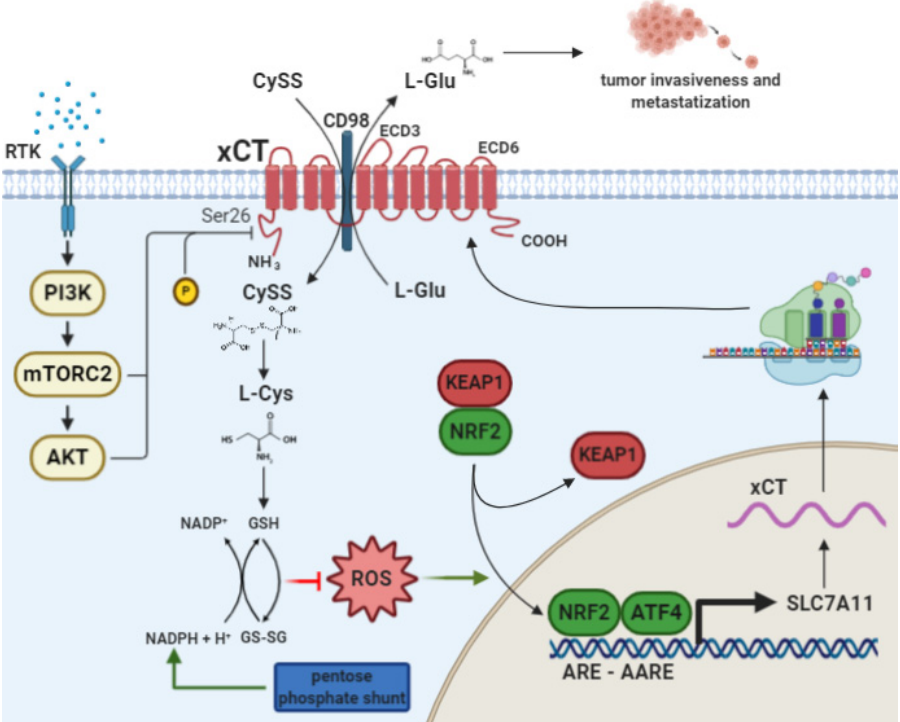
Figure 1. xCT function and transcriptional regulation. The cystine/glutamate antiporter xCT exports intracellular glutamate and imports extracellular cystine. Exported glutamate is involved in tumor microenvironment shaping, promoting invasiveness and metastasization. The imported cystine is reduced to cysteine and used for the biosynthesis of GSH, which is responsible for cancer cell protection from reactive oxygen species (ROS) excess due to genomic instability, altered metabolism and external insults, such as chemotherapy. ROS induce the upregulation of xCT, which destabilizes the KEAP1-NRF2 complex; NRF2 translocation into the nucleus and its binding to the ARE sequence on the SLC7A11 gene promoter lead to xCT mRNA transcription and protein production. Amino acid depletion also induces xCT upregulation through ATF4, which binds to the Amino Acid Response Element (AARE) sequences on the SLC7A11 gene promoter. The mTORC2/AKT signaling axis is another relevant pathway in xCT post-translational modulation that, when activated, inhibits xCT through Ser26 phosphorylation. This figure was created with BioRender.com.